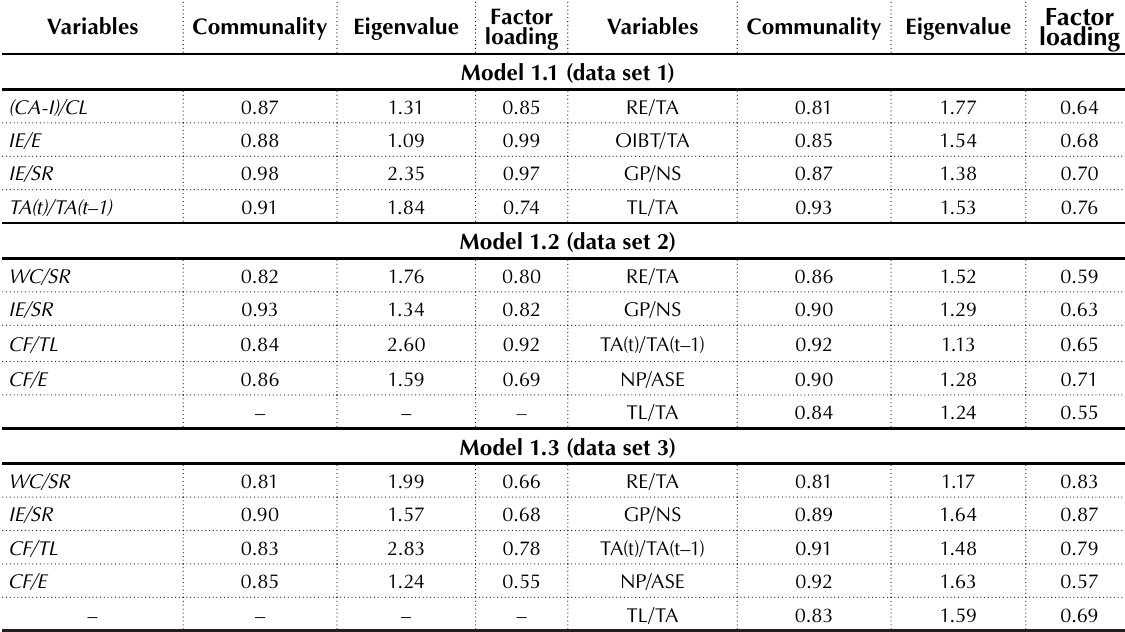
Table A4. Results of factor analysis – variable set